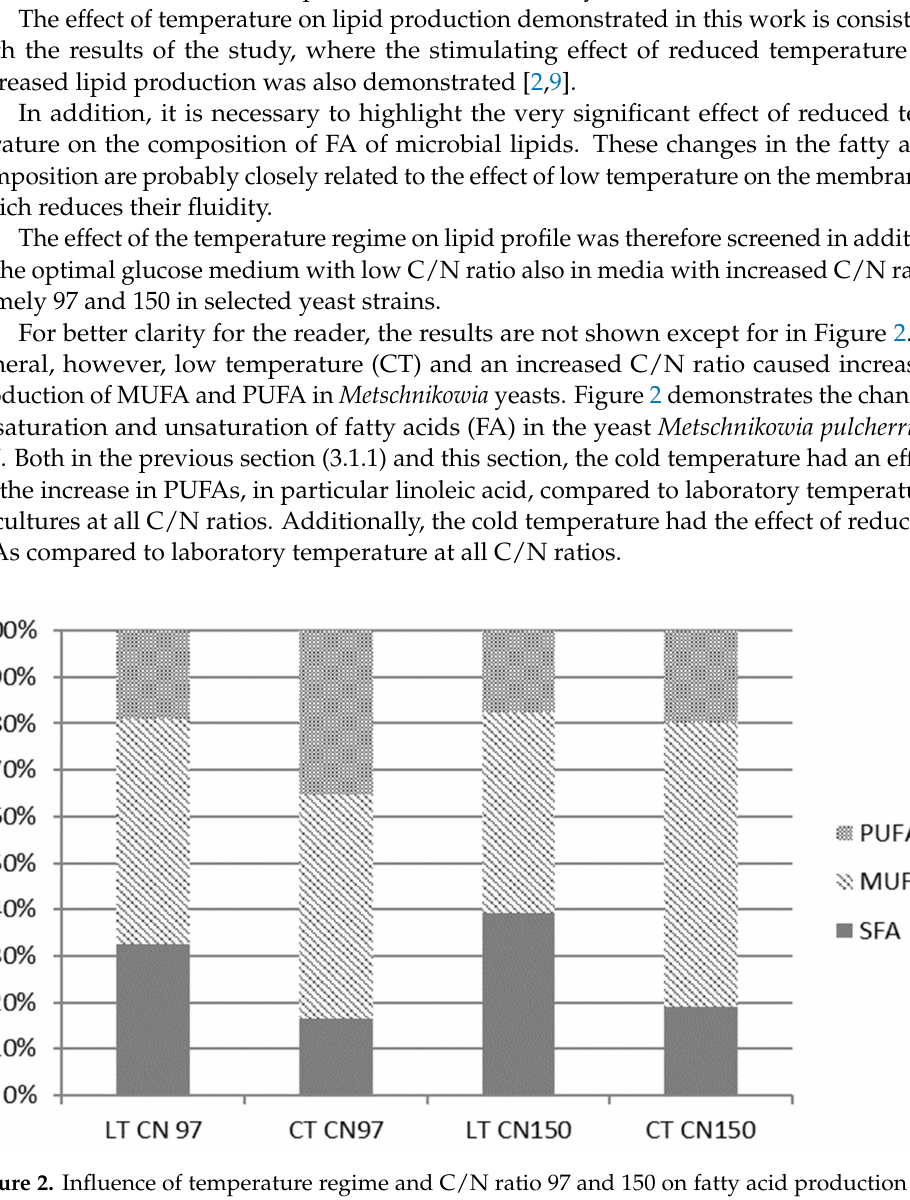
Figure 2. Influence of temperature regime and C/N ratio 97 and 150 on fatty acid production ( M. pulcherrima